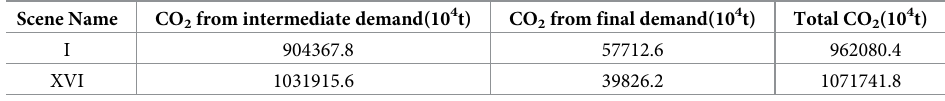
Table 2. The measurement of carbon emissions under the scenario XVI and scenario I.